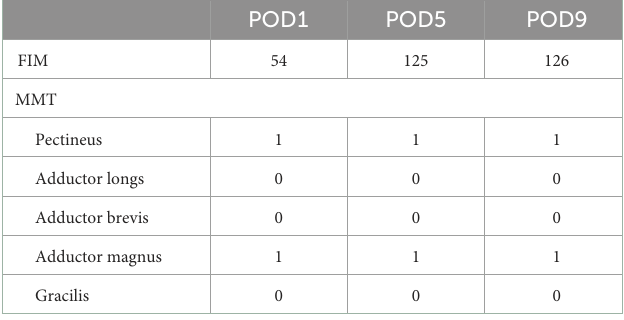
TABLE 1 Postoperative changes in manual muscle testing (MMT)